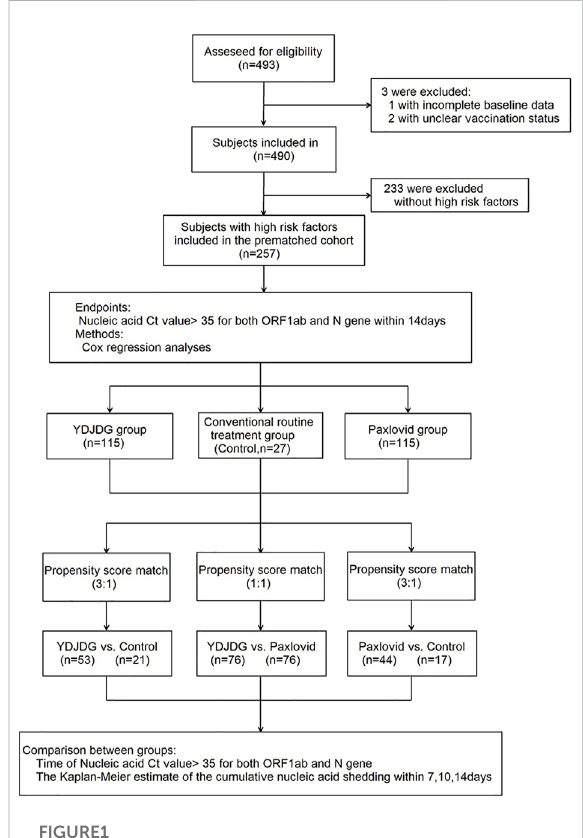
FIGURE1 Flow chart of the clinical research. A total of 493 participants were screened for eligibility; 257 patients were included in the research. The Cox regression model was used to analyze the independent factors affecting the nucleic acid shedding time after a follow-up of 14 days. Propensity score matching (PSM) was usedtomatchthecharacteristicsofindividualsinthethreegroups. The nucleic acid shedding time and proportion of nucleic acid shedding at 14 days were compared separately. COVID-19, coronavirus disease 2019; YDJDG, Yindan Jiedu